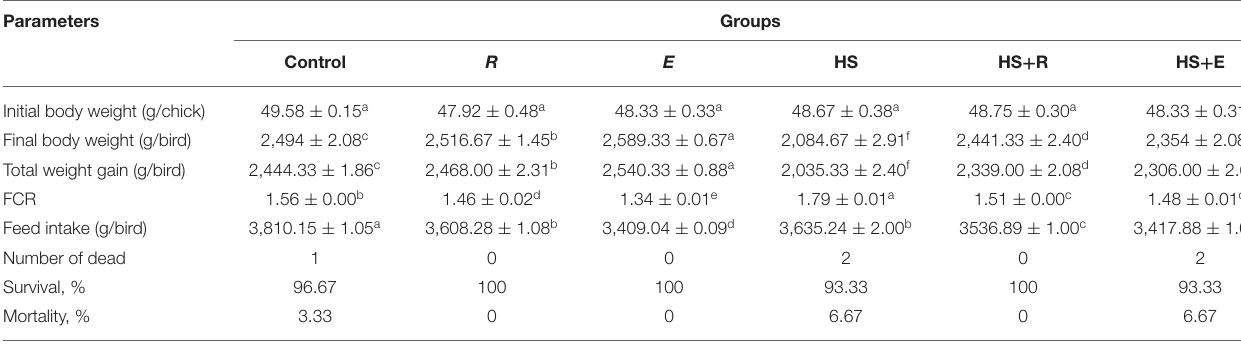
TABLE 3 | Effects of supplementation with digestive enzymes and/or Ruminococcus sp. on the growth performance of broiler chicken under heat stress (at day 42), n = 30. Parameters